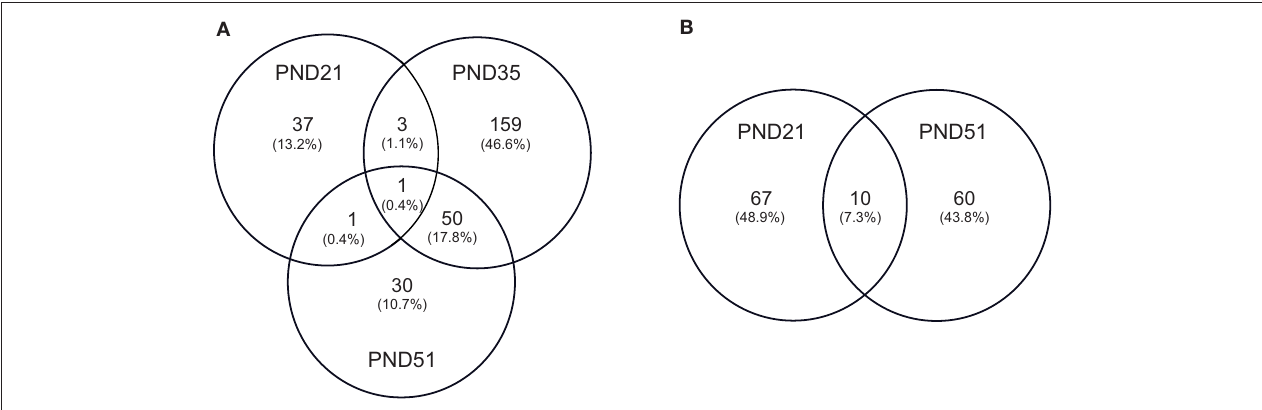
FIGURE 1 | Target predicted genes in MF fed piglets relative to HM fed piglets at PND 21, 35 and 51. (A) Venn diagram shows unique and shared genes of downregulated miRNA in MF relative to HM at each time point. (B) Venn diagram shows unique and shared genes of upregulated miRNA in MF relative to HM at each time point. The data represents from piglets of 9 MF and 9 HM at PND21, 4 MF and 4 HM at PND 35, and 9 MF and 10 HM at PND 51.